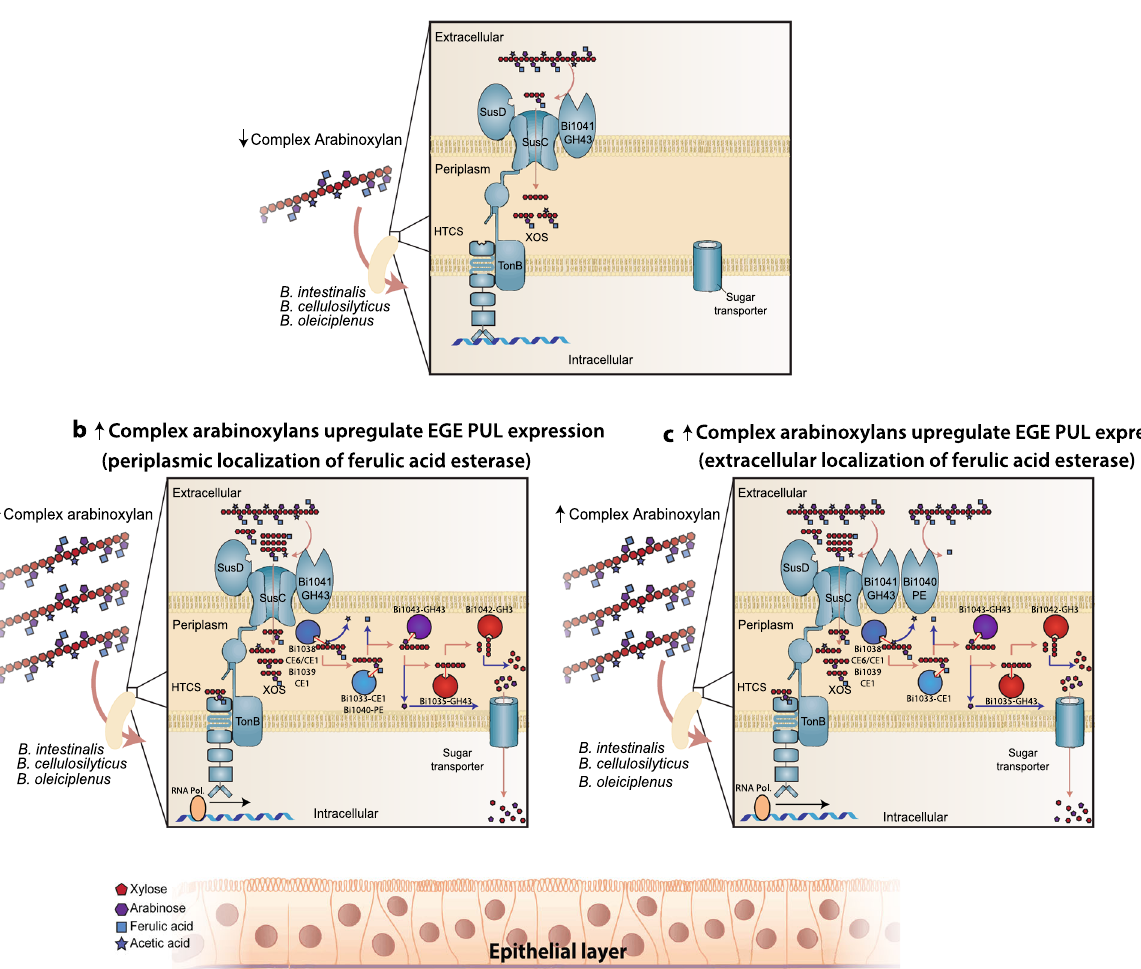
Fig. 10 A model predicting the regulation of the EGE PUL in B. intestinalis . a In the absence or during low amounts of complex arabinoxylan ( ↓ ), the Bacteroides spp. containing the EGE PUL express basal levels of core polypeptides, i.e., the SusC/SusD transporter, the endo-acting enzyme